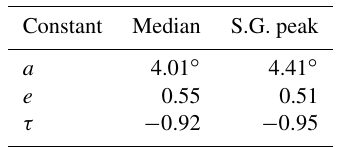
Table 2. Boundary fit constants for DMSP − AMPERE boundary